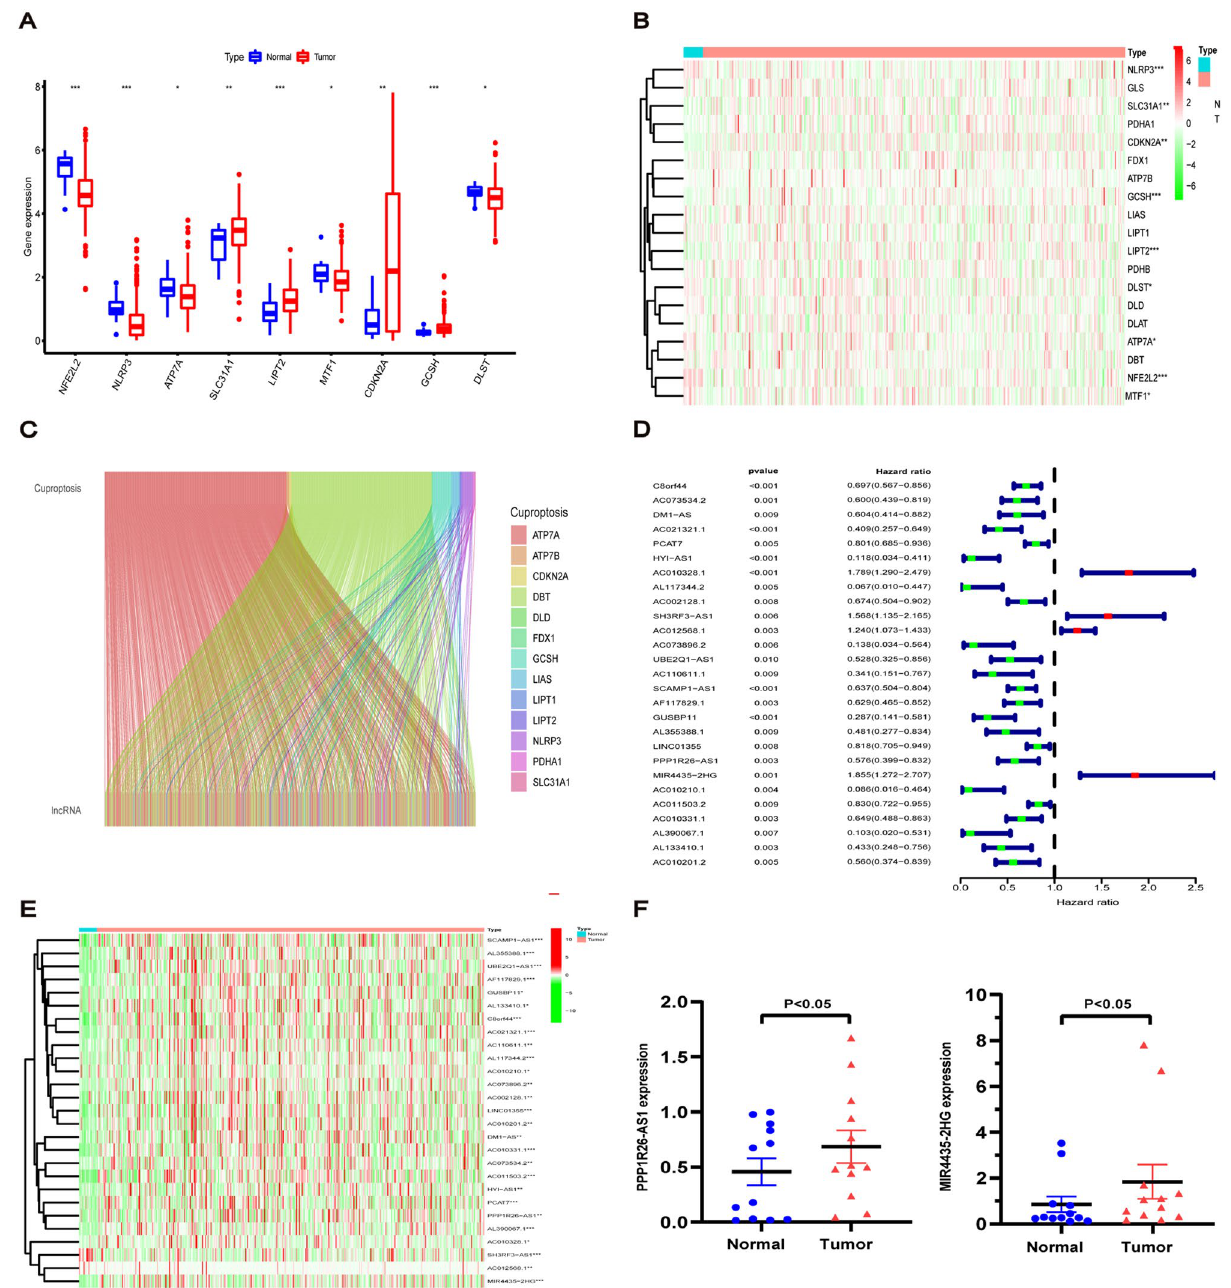
Figure 2. Identification of cuproptosis-related lncRNAs in BC. ( A ) Differential expression of 19 cuprotosis genes between BC tissues and normal tissues. ( B ) The heatmap of 19 cuprotosis genes with color green for low- expression and color red for high-expression. ( C ) Sankey relational plot for cuprotosis genes and cuproptosis- related lncRNAs. ( D ) Forest plot of 27 cuproptosis-related lncRNAs identified to be significantly correlated with prognosis. ( E ) The heatmap of 27 cuproptosis-related lncRNAs associated with survival. ( F ) Expression of MIR4435-2Hg and PPP1R26-AS1 in 12 pair of bladder cancer and adjacent tissues. * P < 0.05, ** P < 0.01, and *** P <